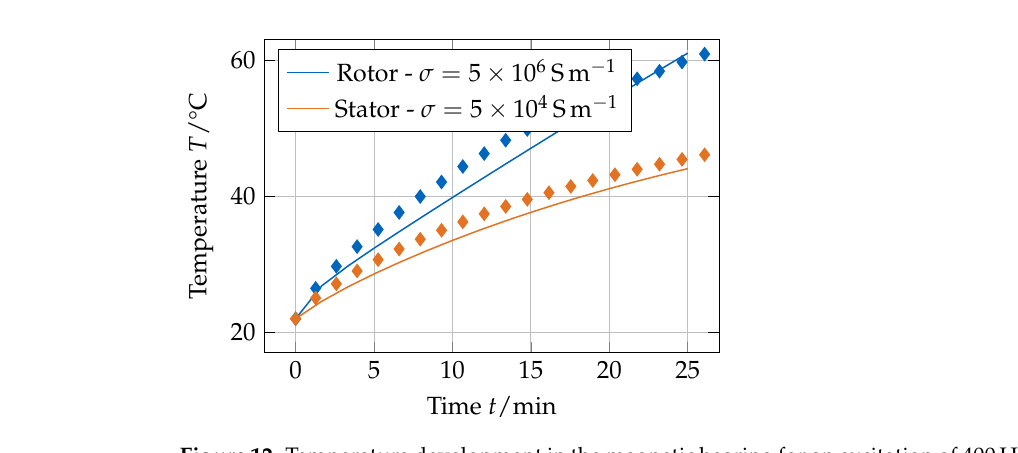
Figure 12. Temperature development in the magnetic bearing for an excitation of 400Hz and I c = 5A.